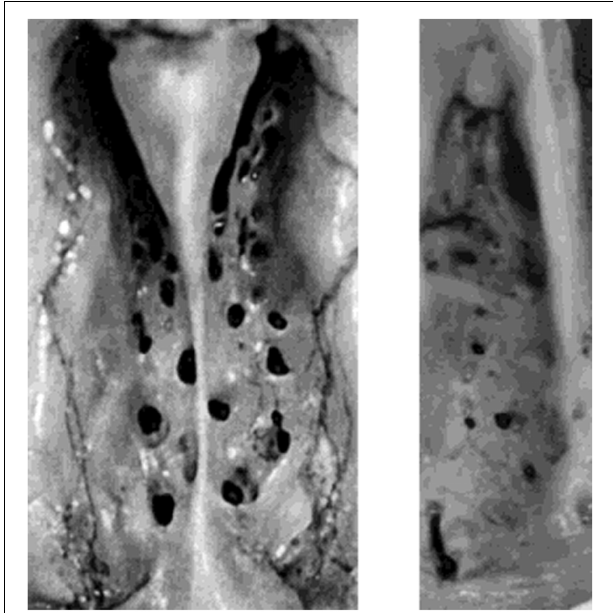
FIGURE 11 | Left: left and right halves of the cribriform plate of a 25-year-old female in superior view. Right: left half of cribriform plate of a 66-year-old male in superior view. Note the difference in size and number of patent foramina that transmit cranial nerve I between the young and old cribriform plates. Anterior is toward top. From Kalmey et al. (1998), with permission. Copyright©1998, Wiley-Liss,